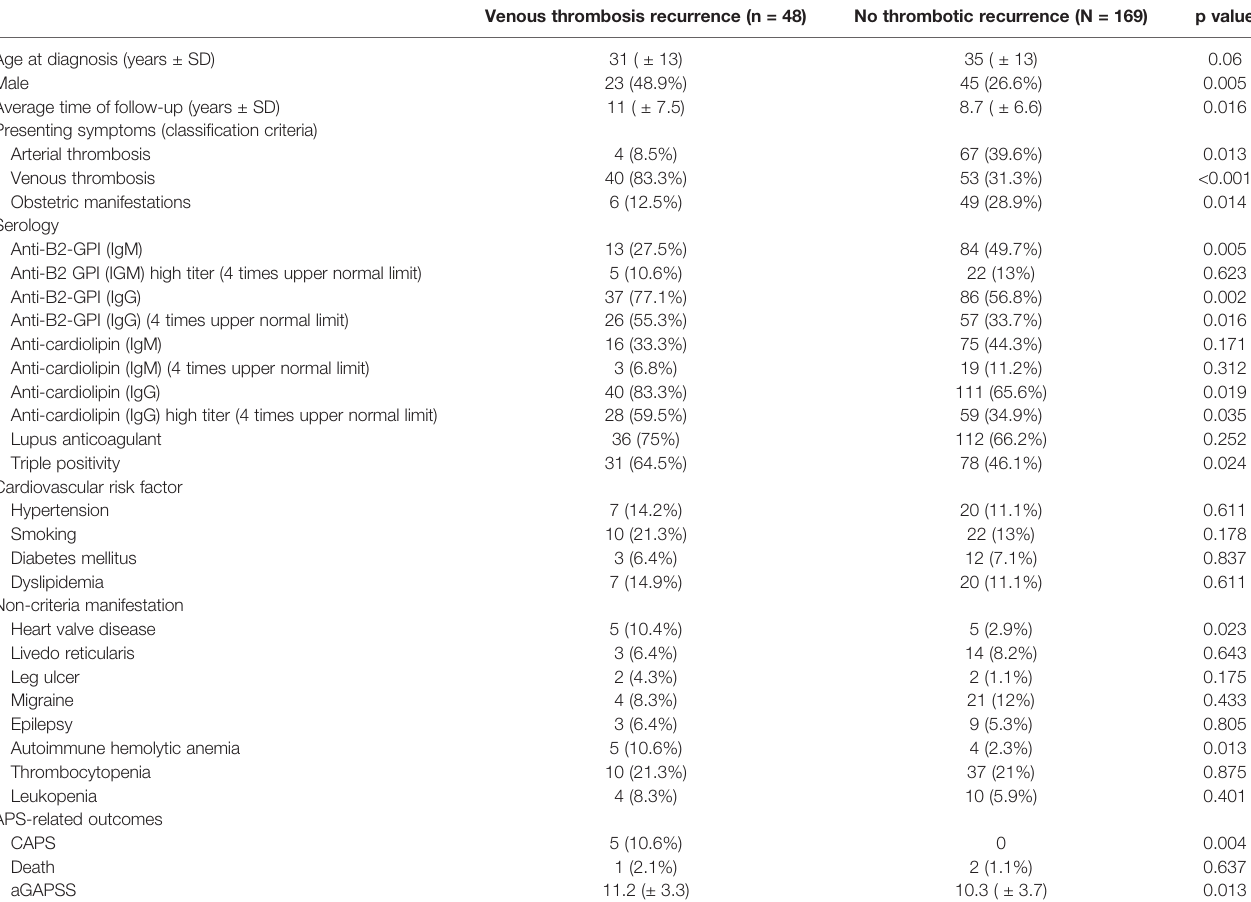
TABLE 3 | Clinical and serological parameters associated with the “ venous pattern ” .